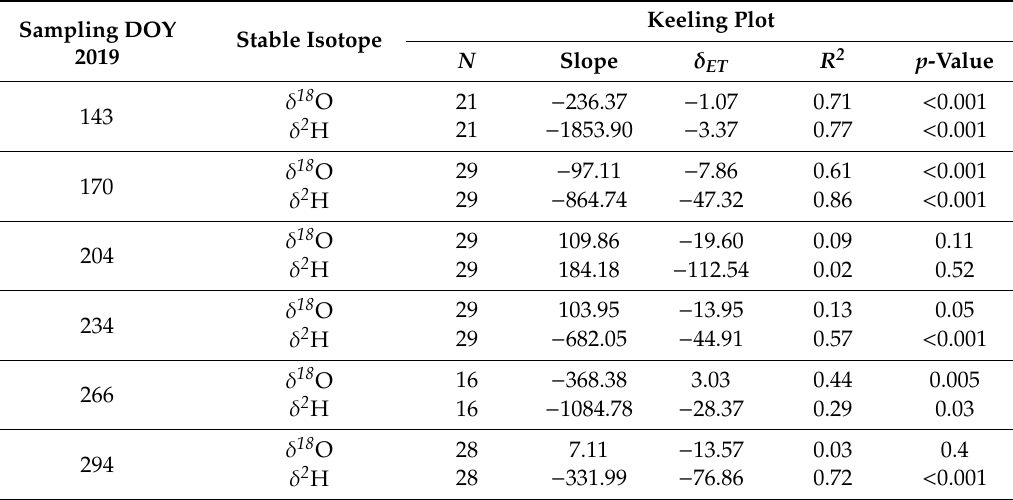
Table 1. Descriptive statistics for linear regression (Keeling Plot) analyses for sampling events during the growing season. Sample size ( N ) is the total of water vapor data from 10:30 to 14:00 at five di ff erent heights in the forest canopy for each sampling day. DOY, Day of Year.